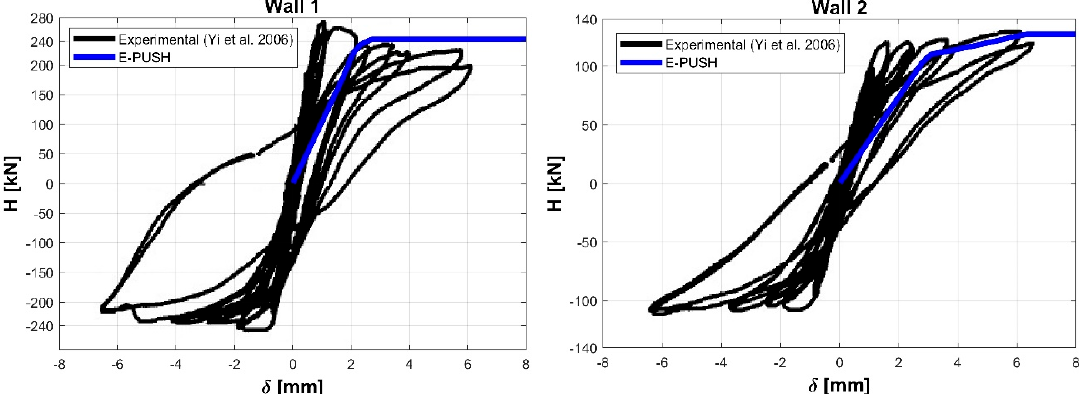
Figure 7. Comparison of capacity curves of walls 1 and 2 with experimental 𝐻 − 𝛿 test results [22].